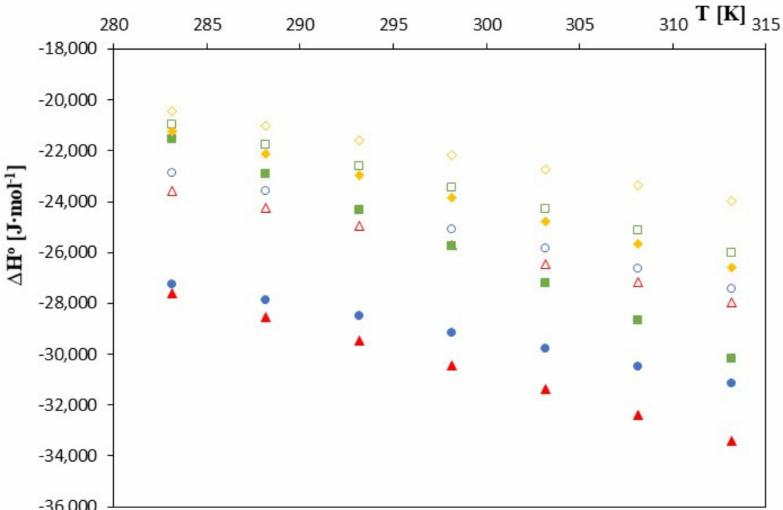
Figure 5. The plots of dependence ∆ H 0 [J · mol − 1 ] in the function T [K] for β -cyclodextrin with all studied salts.: - trans -cinnamic acid; - trans –p-coumaric acid; - trans -caffeic acid; - trans -ferulic acid and 2-HP- β -cyclodextrin with the studied salts.: - trans -cinnamic acid; - trans –p-coumaric acid; - trans -caffeic acid; - trans -ferulic